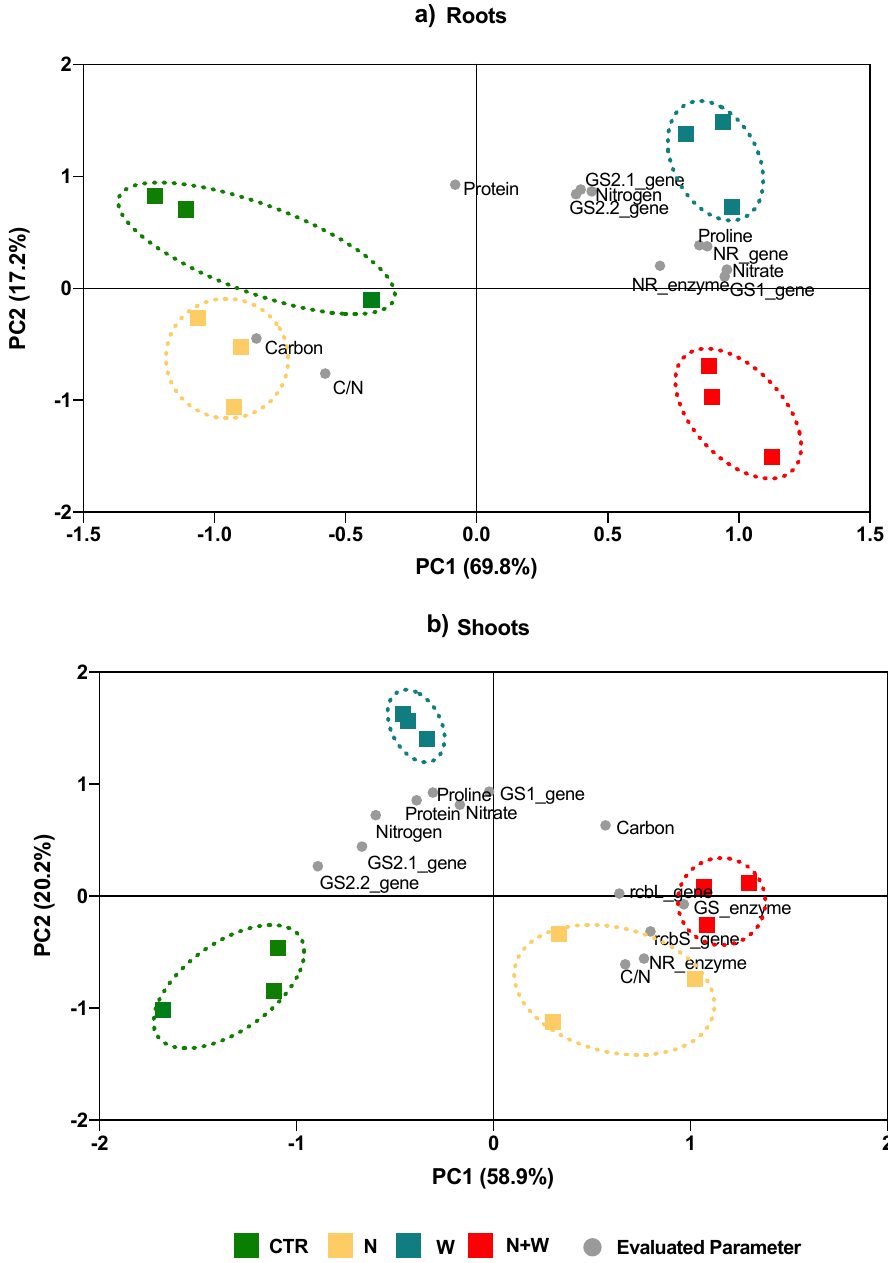
Figure 9. Principal component analysis (PCA) of the plant metabolism in roots ( a ) and shoots ( b ) evaluated in tomato cv. Micro-Tom grown for 16 days under (CTR; 10.5 mM N + 100% W), nitrogen deficit (N; 5.3 mM N + 100% W), water deficit (W; 10.5 mM N + 50% W) or combined nitrogen and water deficit (N+W; 5.3 mM N + 50% W). The two principal components (PC1, PC2) explained 87% and 79% of the total variance found among treatments in roots and shoots, respectively. Details on the abbreviations are given in Material and Methods.